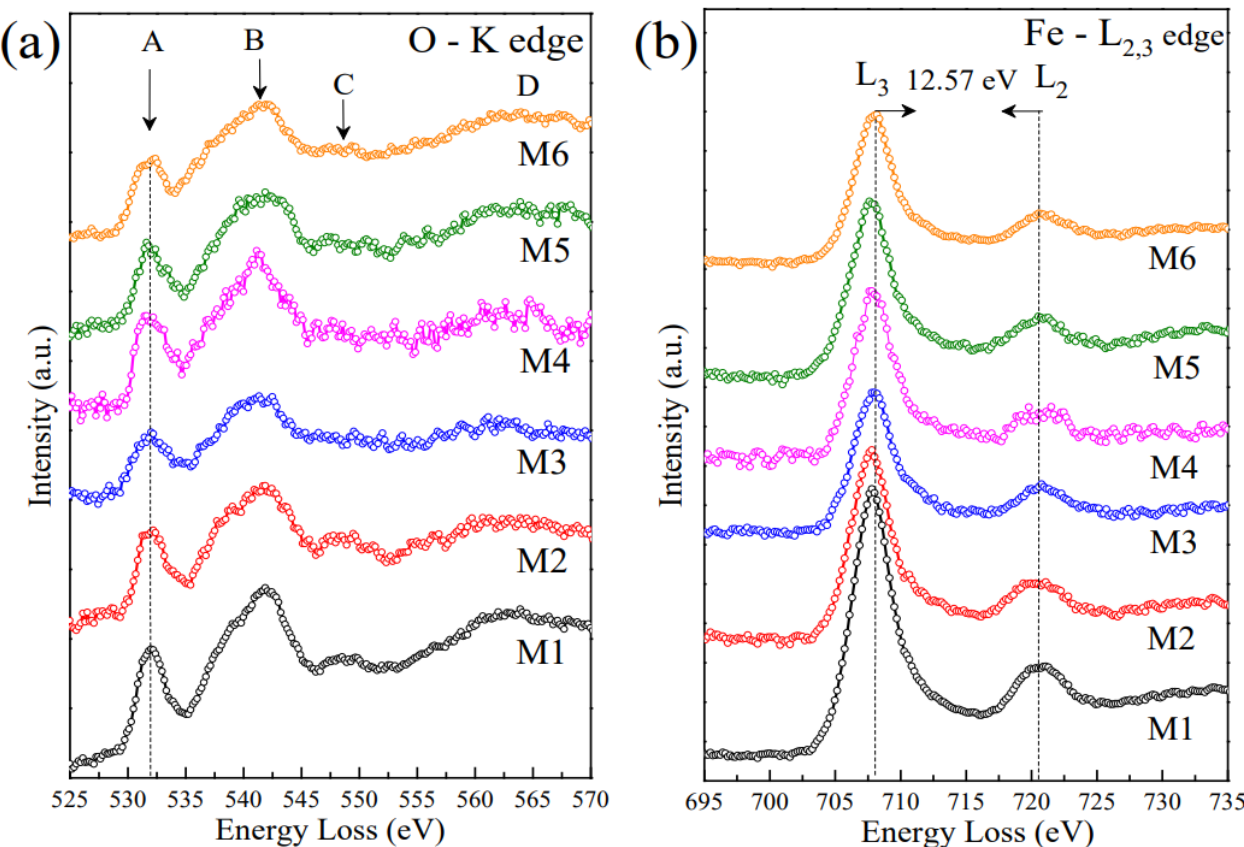
Figure 7. EELS spectra of the M1 – M6 samples. ( a ) O-K edge and ( b ) Fe-Le 2,3